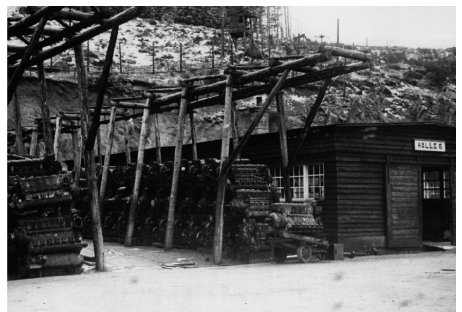
Figure 3 : View of Hall 6 and stock of aircraft engines